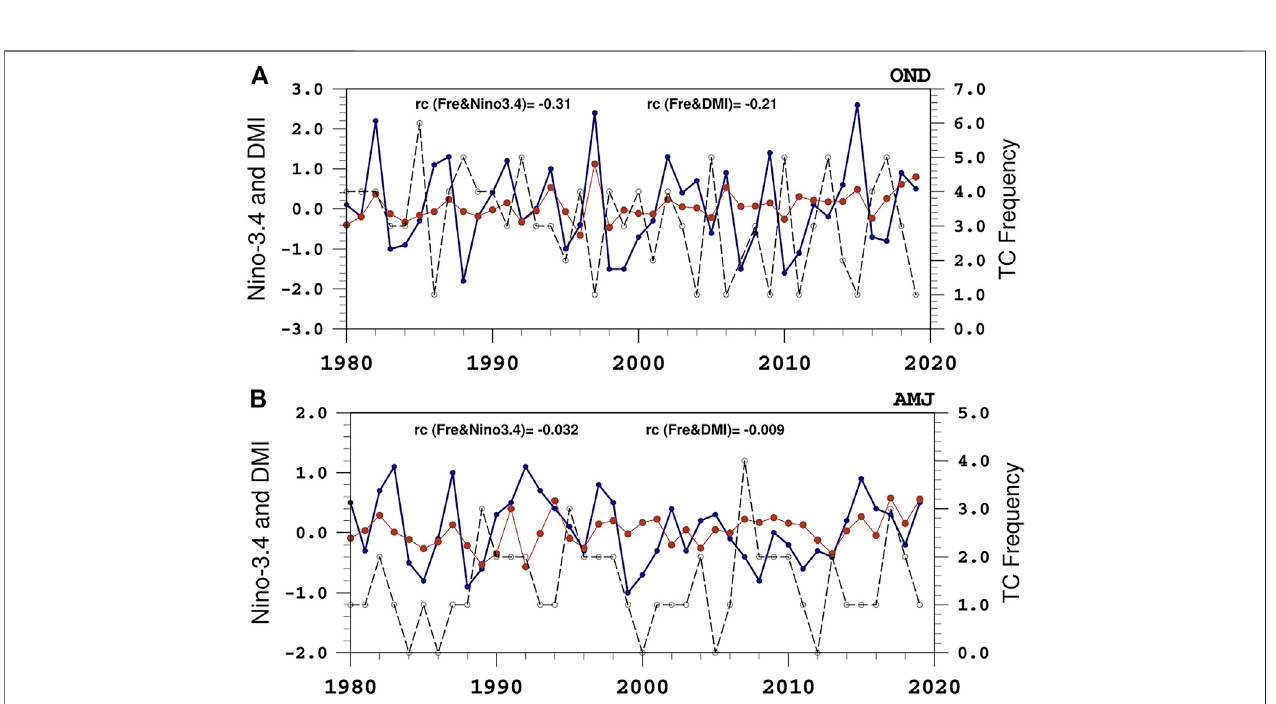
FIGURE 2 | Time series of the October-December (OND) TC frequency (in black) over the BoB, the Niño-3.4 index (in blue), and DMI index (in brown) during 1980 – 2019; rc indicates their correlation coef fi cients (A) . (B) Same as (A) but for April – June (AMJ).